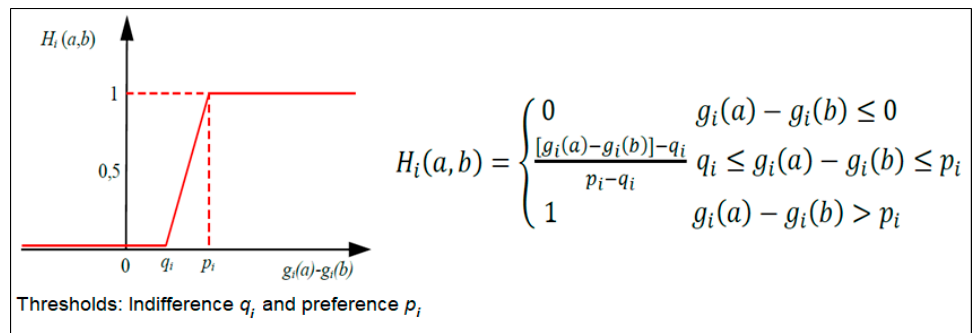
Figure 6. Linear preference function—the Promethee method [18,19].